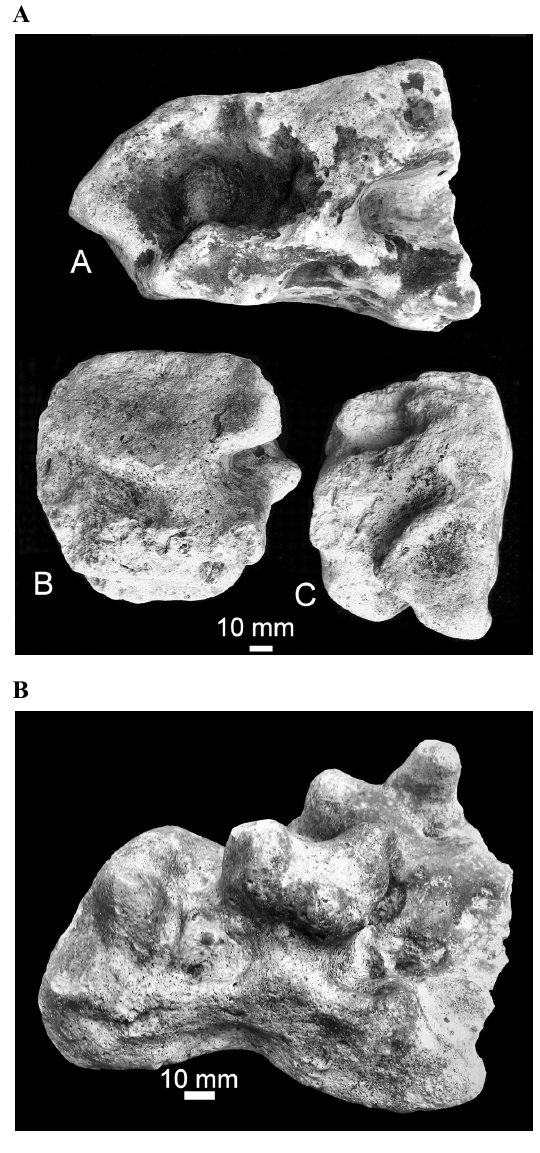
Fig. 2. A , boulders of baksteenkalk type 1: A, RGM 1317626, Itterbeck; B, RGM 1317627, Kloosterhaar; C, RGM 1317628, Kloosterhaar. B , a particularly knobby, undulose boulder of baksteenkalk type 1. RGM 1317629,